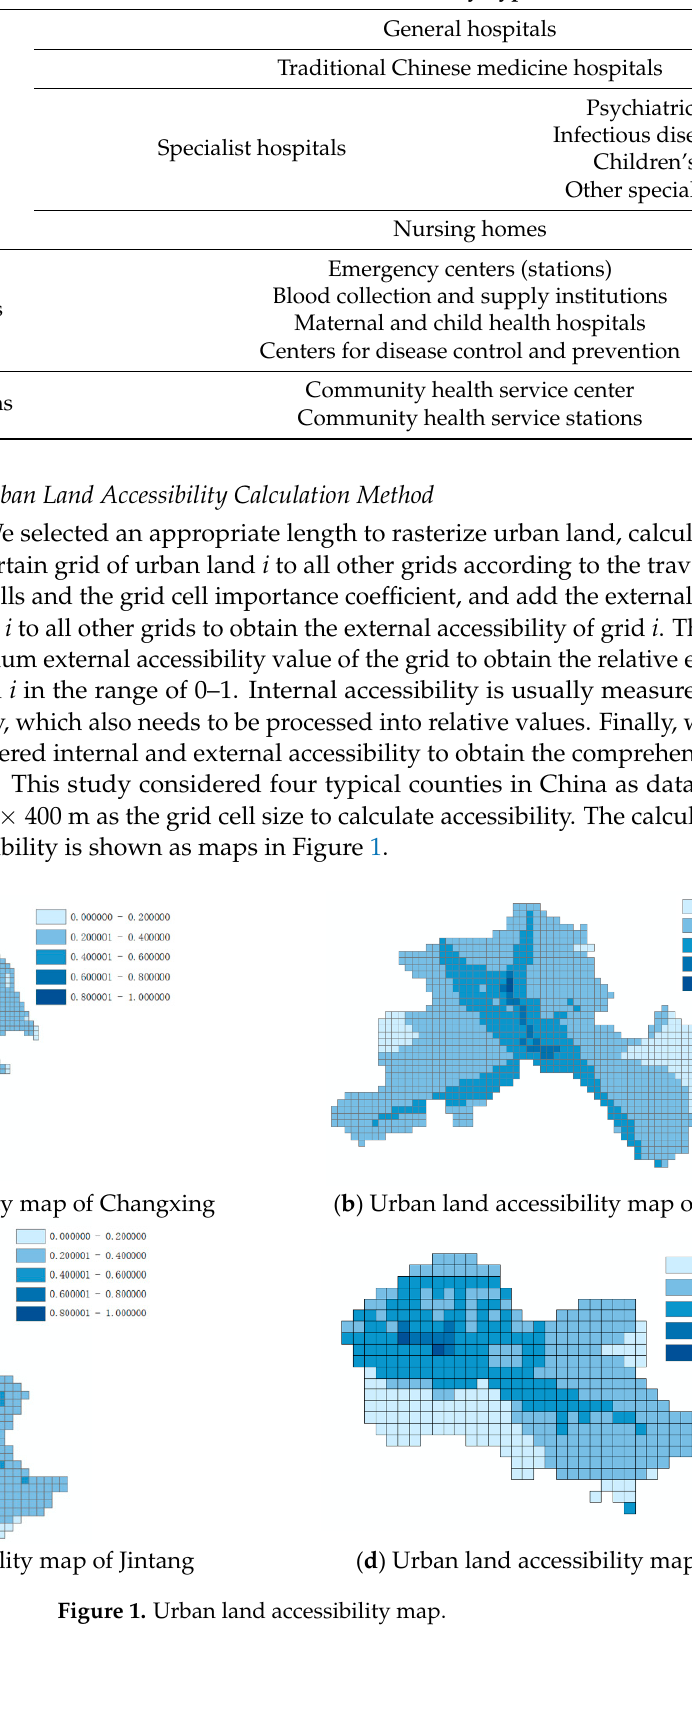
Table 2. Educational facility categories in the Standard for Urban Public Service Facilities Planning. Facility Category